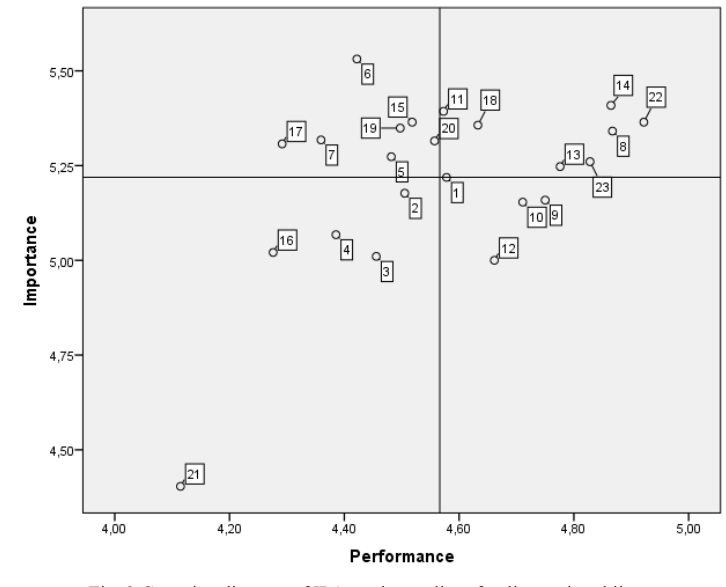
Fig. 2 Cartesian diagram of IPA on the quality of online taxi mobile